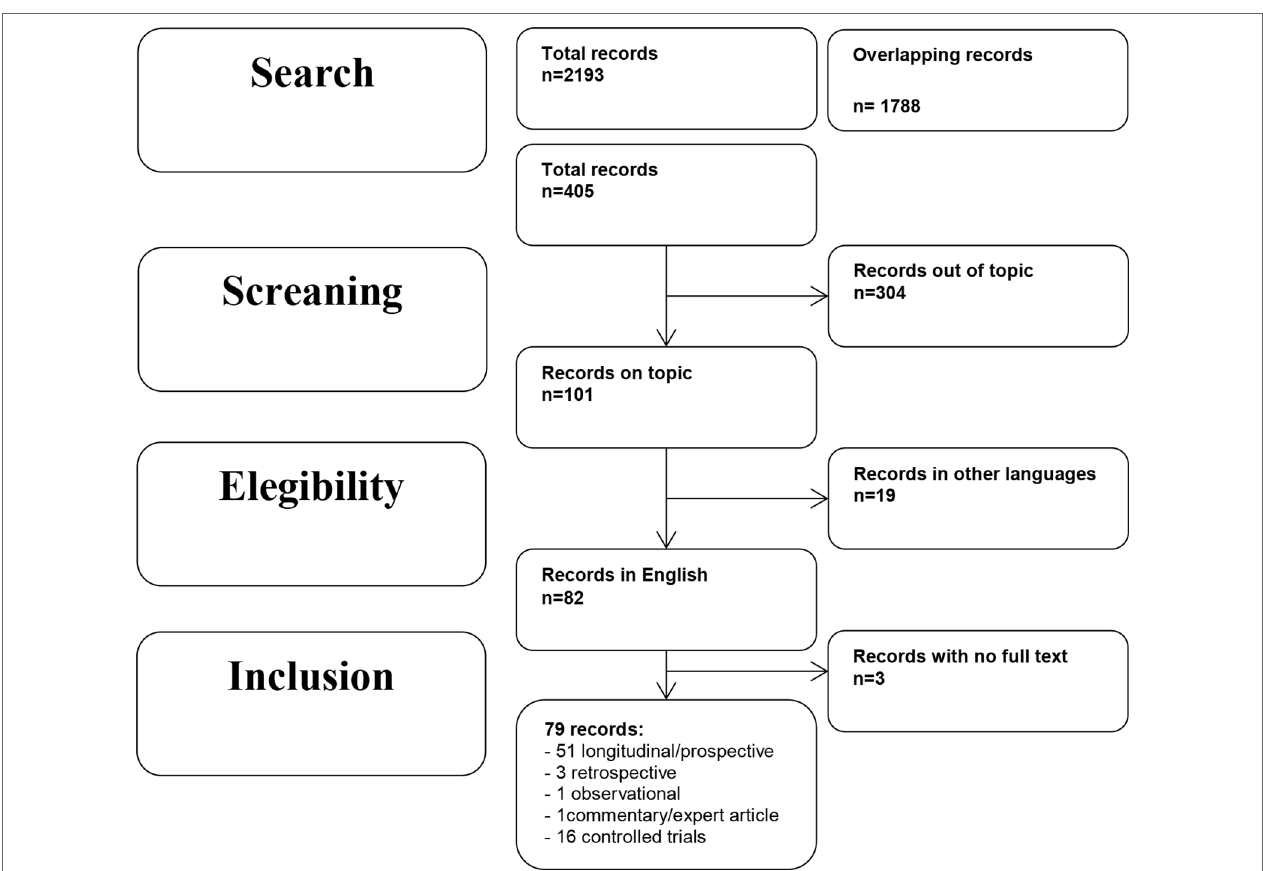
FIGURE 1 | Literature search